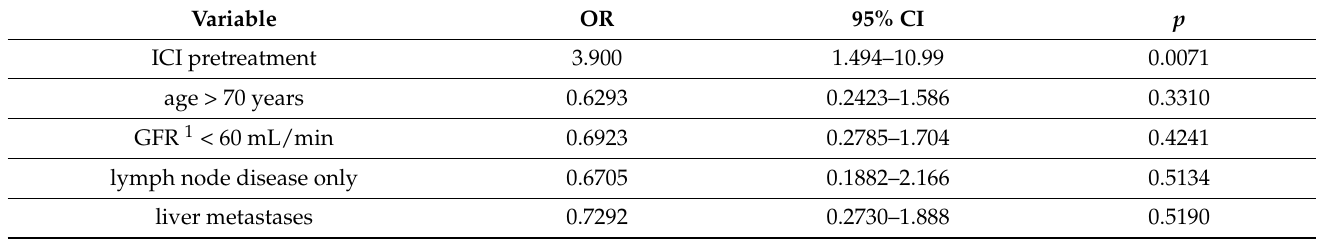
Table 4. Univariable binary logistic regression analysis of considerable treatment effect (SD, PR, or CR) in all patients.